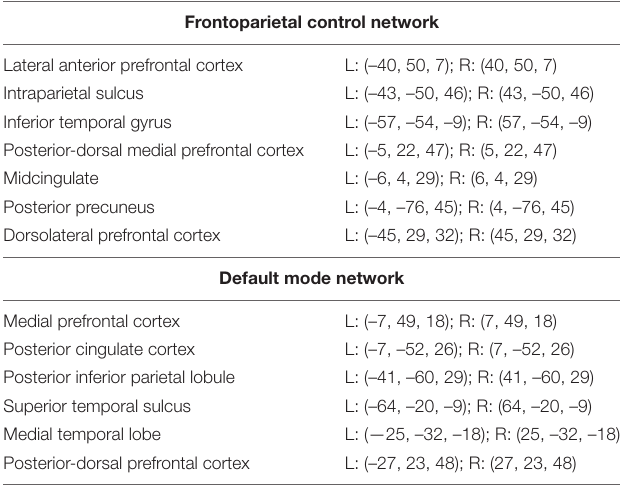
TABLE 1 | Spherical regions of interest (ROIs) and their associated MNI coordinates. Frontoparietal control